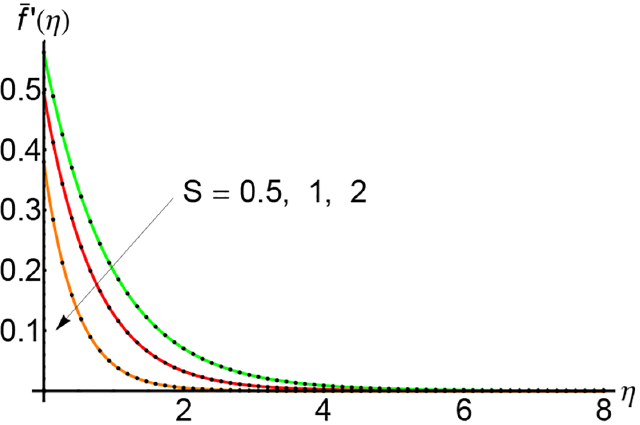
Fig 11. Variation of shear stress (cid:2) f 00 ð Z Þ with η for different values of suction parameter S and for λ = 0.5: —— numerical solution ......... . OHPM solution.